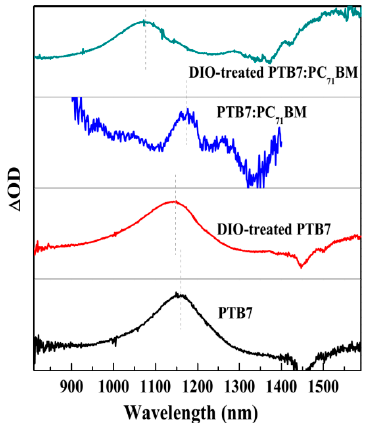
Figure 7. SEC spectra of PTB7-based active layers. All the differential spectra were taken as the difference between the spectra recorded with and without the applied potential. The spectral range of PTB7 •+ was only exhibited in 810–1600 nm owing to experimental conditions.